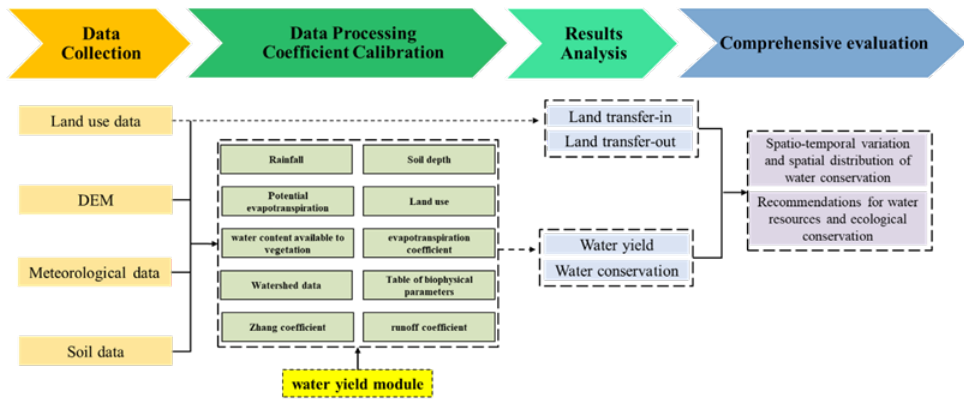
Figure 3. Research framework.